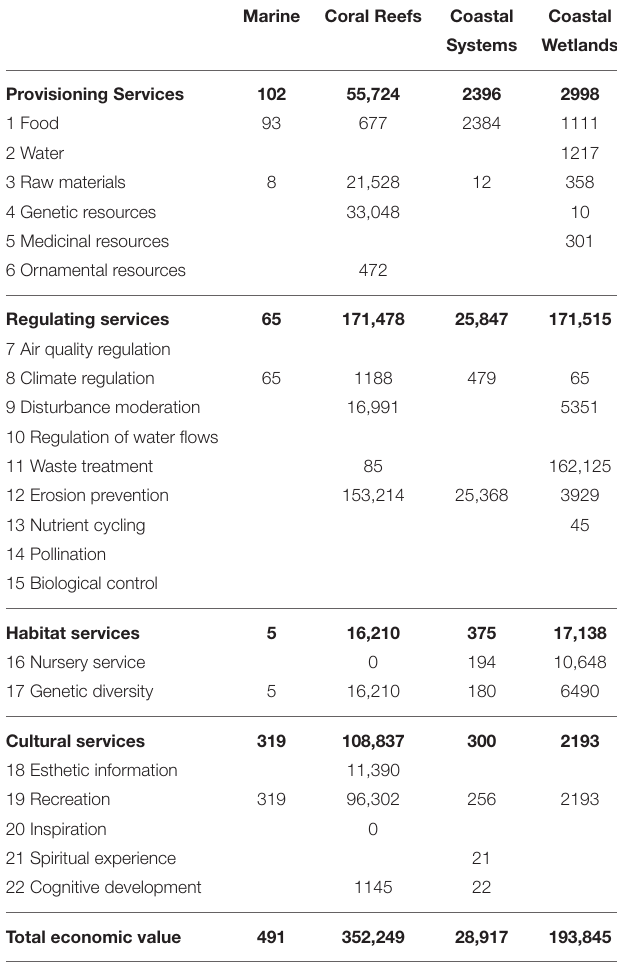
TABLE 1 | Summary of monetary values for each service per biome (values in Int.$/ha/year, 2007 price levels; de Groot et al., 2012). Marine Coral